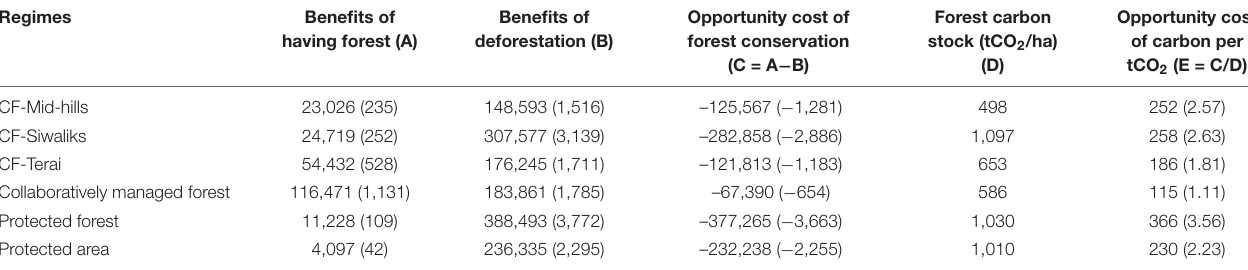
TABLE 3 | Annual benefits and costs of reducing deforestation in NPR per ha (USD in